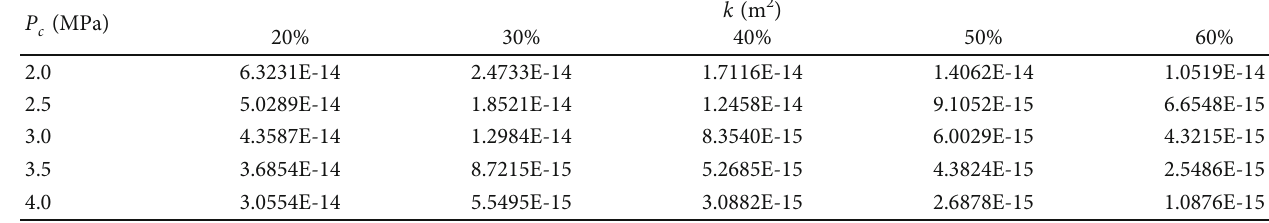
ff erent clay mineral proportions S . c under di